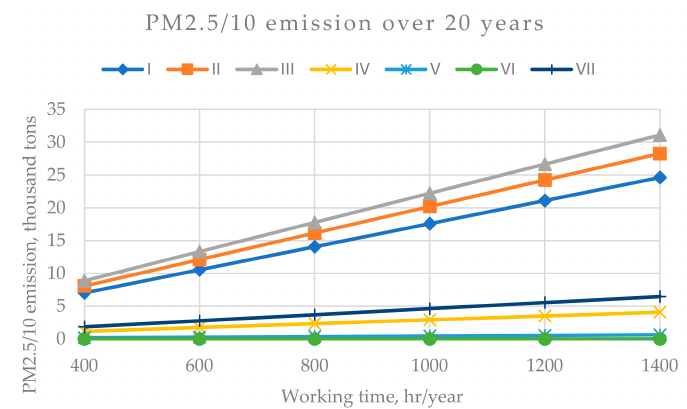
Figure 7. PM2.5 and PM10 dust emissions of individual heating systems for an operating time of 400